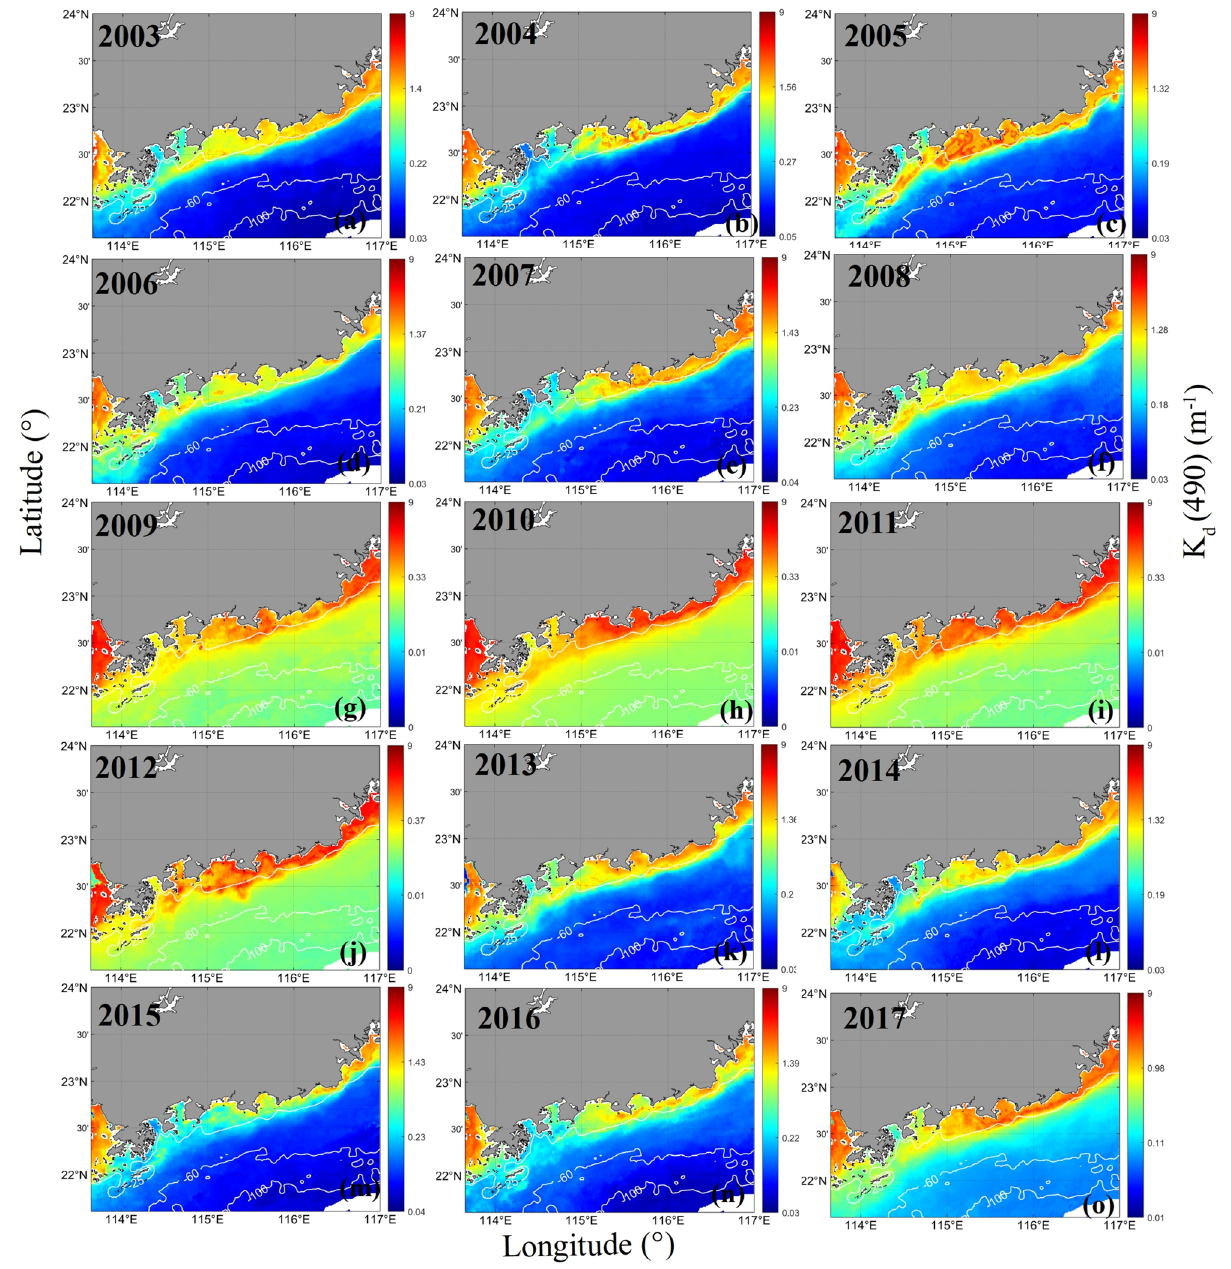
Figure 3. The mean K d (490) values (m −1 ) between November and December from 2003 to 2017.The program R (version 3.6.3, available at https:// www.r- proje ct. org) was applied for the C tsm were higher in autumn and winter than in spring and summer. The corresponding fronts observed in the K d (490) and C tsm series were identified in the EGD coastal waters. The sediments in the Fujian-Zhejiang coastal waters (ZFC) of the East China Sea (ECS) could be advected to the EGD coast by the strong coastal currents. For areas with depths of less than 25 m, the water is mixed well from top to bottom due to downwelling. For areas with water depths between 25 and 60 m, thermoclines and haloclines could be found at depths of 15 m in the EGD 29 . The thicknesses of these thermoclines and haloclines were found to be approximately 5 ~ 10 m. These thicknesses increased with the water depth. The thermocline intensity was approximately 0.2 °C m −1 , and the halocline intensity was more than 0.05 m −129 . Figure 6 shows that the strength of downwelling near the Wanshan Archipelago was relatively strong in 2005 and weak in 2009. This is in accordance with the strength of the fronts observed in the K d (490) and C tsm series. The time series of the mean K d (490) anomalies and the mean Ekman pumping velocities in coastal waters with depths less than 25 m between November and December from 2003 to 2017 are given in Fig. 7. The mean K d (490) anomalies showed an opposite trend with the mean Ekman pumping velocities. This illustrates that K d (490) tended to increase when strong downwelling occurred. The Pearson correlation between the monthly